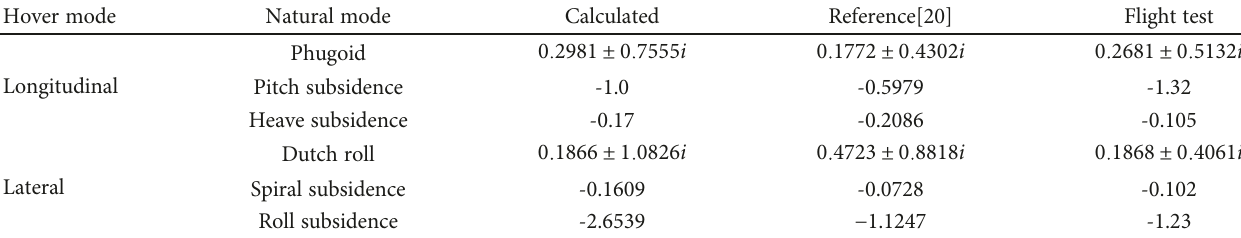
Table 2: Hover mode eigenvalue validation.